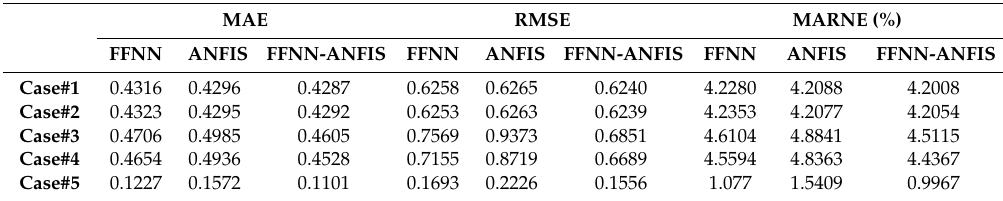
Table 2. Comparison of the forecasting models considering the 10-min-ahead horizon. MAE RMSE MARNE (%) FFNN ANFIS FFNN-ANFIS FFNN